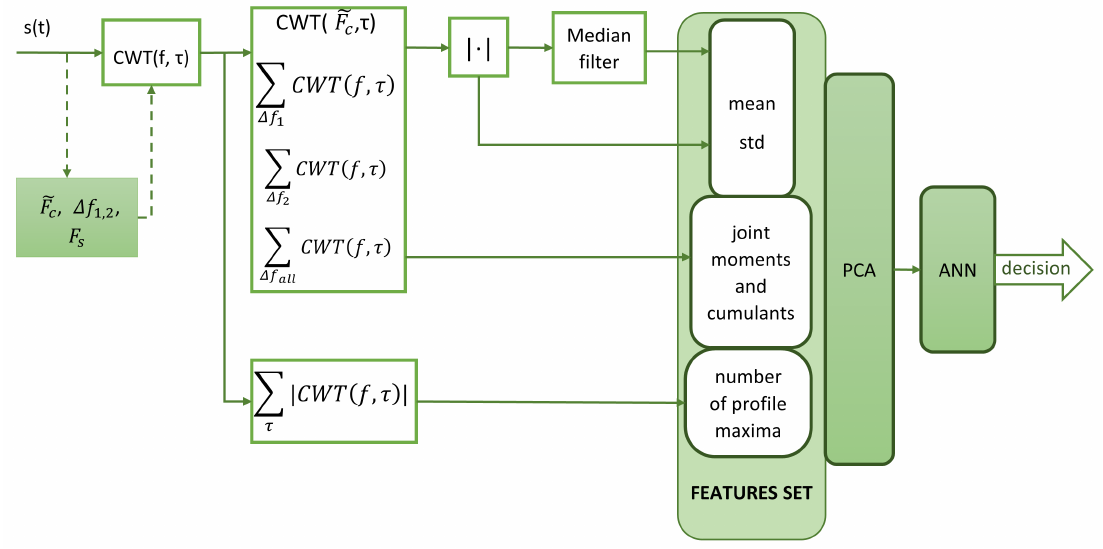
Figure 10. The overall structure of radar signal recognition